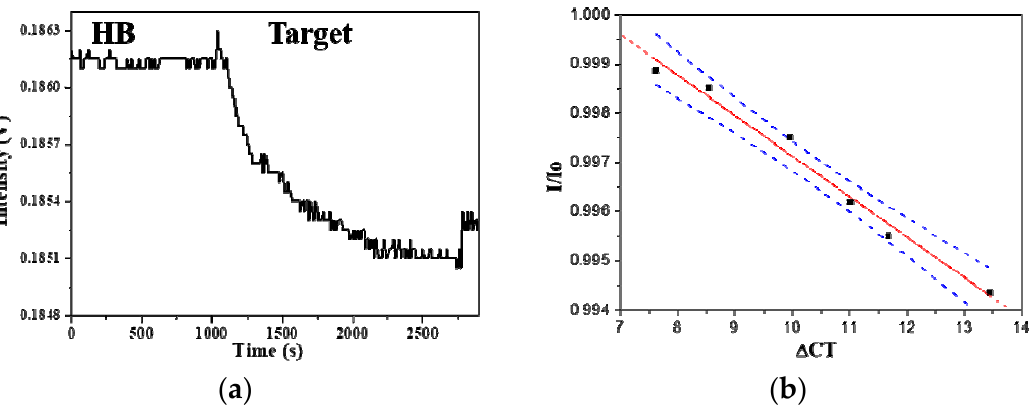
Figure 9. ( a ) Real-time FOPPR sensorgram with HLA-B27 ssDNA probe to detect mRNA in a sample which exhibits a ∆ CT value of 13.64; ( b ) Graph displaying the correlation of results between the FOPPR biosensor and the real-time RT-PCR method for detection of HLA-B27 mRNA in blood samples. Blue dashed lines are the 95% confidence intervals for prediction with the linear regression model.